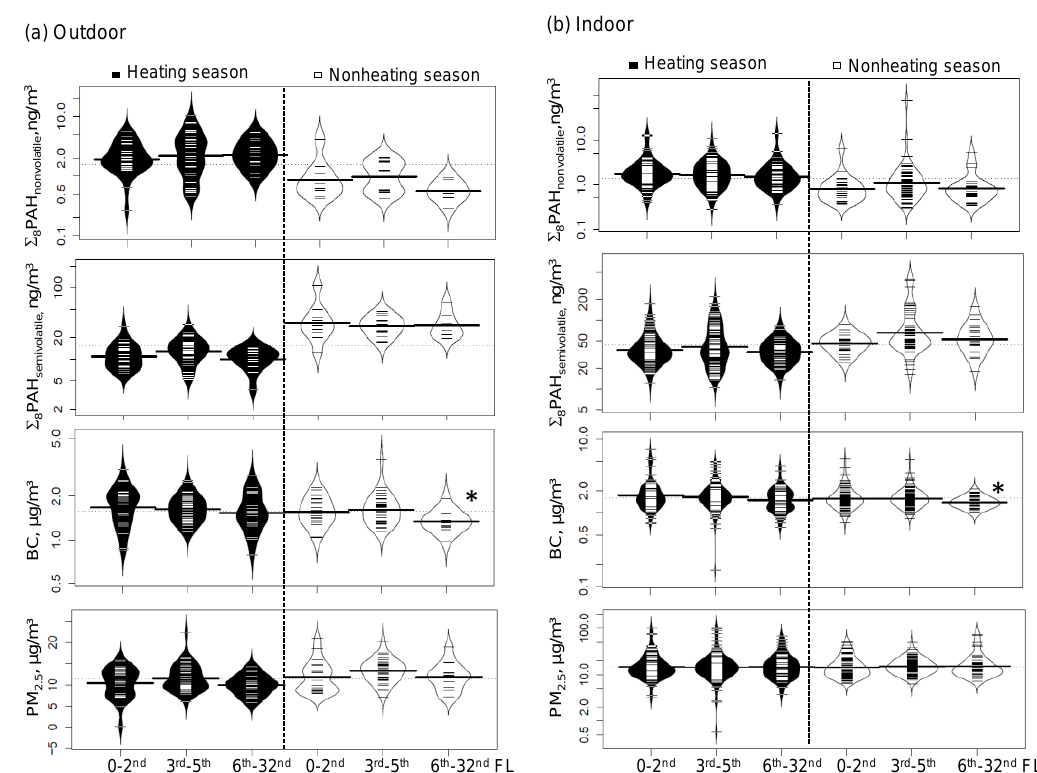
Figure 2. Seasonal variations in vertical distributions of air pollutants measured in ( a ) outdoor, ( b ) indoor